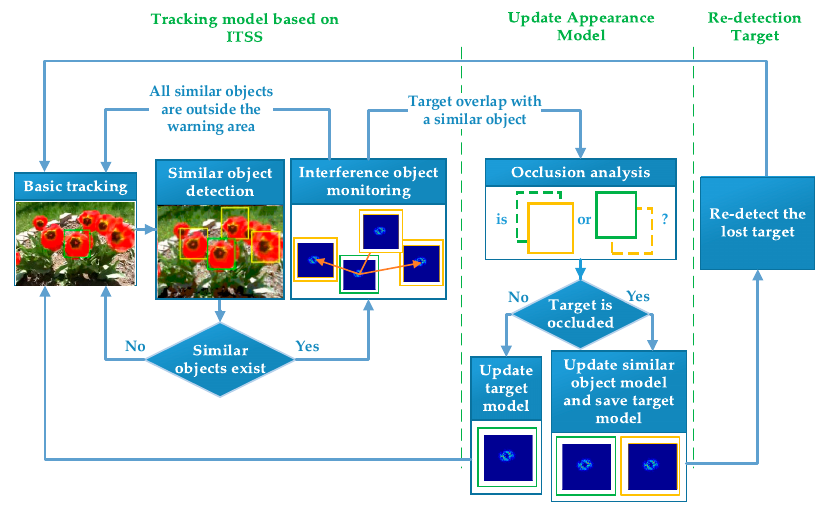
Figure 1. The flowchart of the proposed approach.